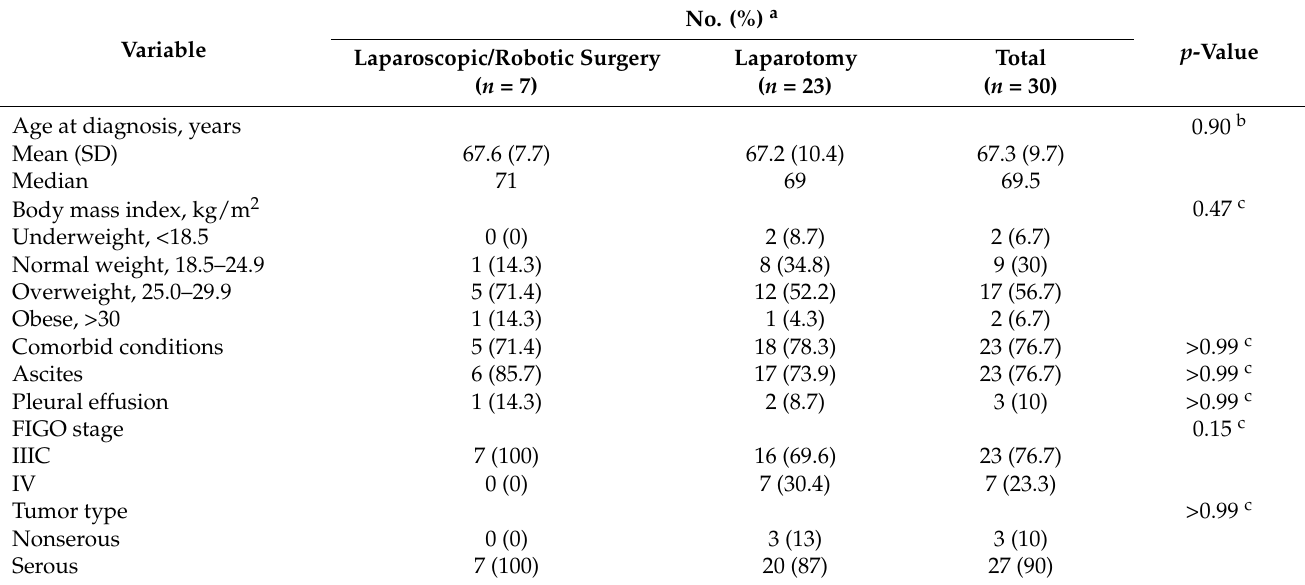
FIGO, International Federation of Gynecology and Obstetrics. a Unless otherwise indicated. b Wilcoxon rank sum test. c χ 2